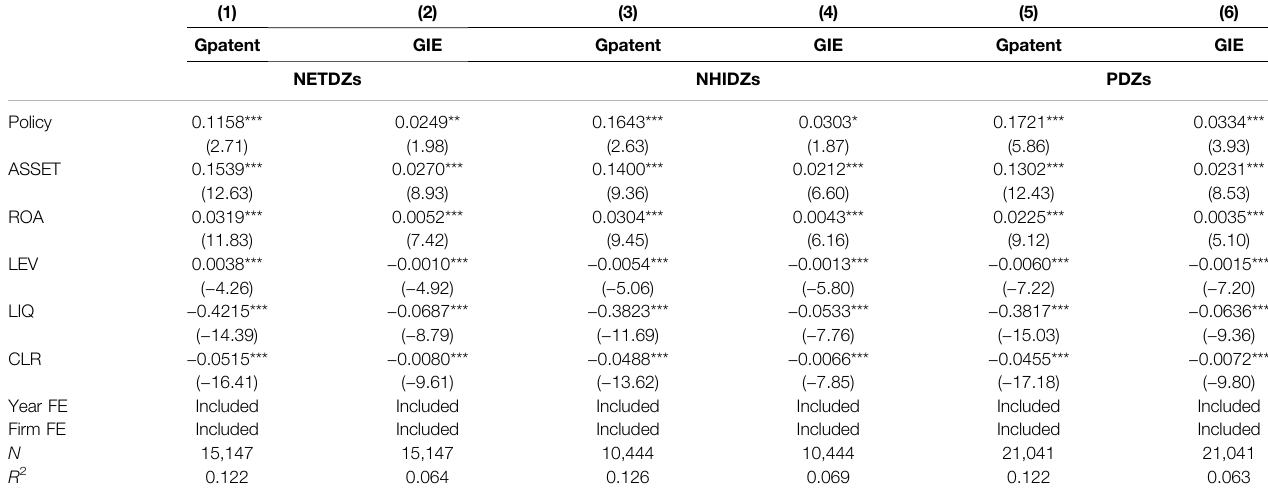
TABLE 3 | Test of heterogeneity.